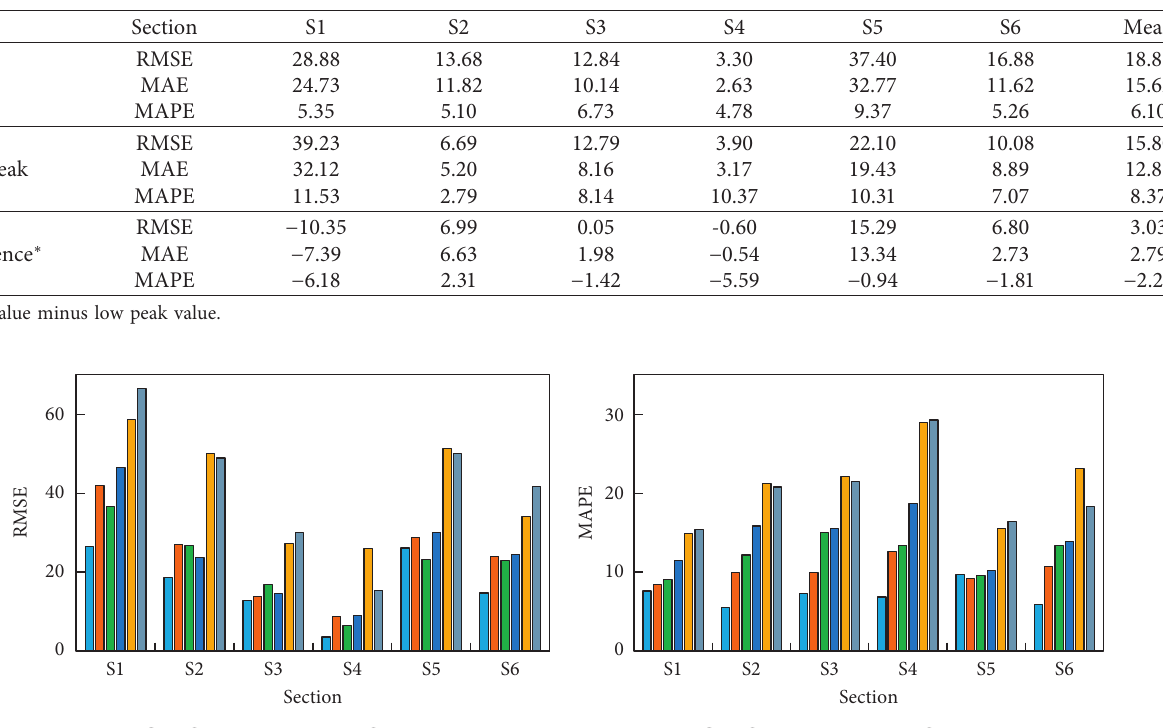
Figure 8: The evaluation values of MAPE, MAE, and RMSE with different time steps. Table 4: Forecasting effect of peak and low